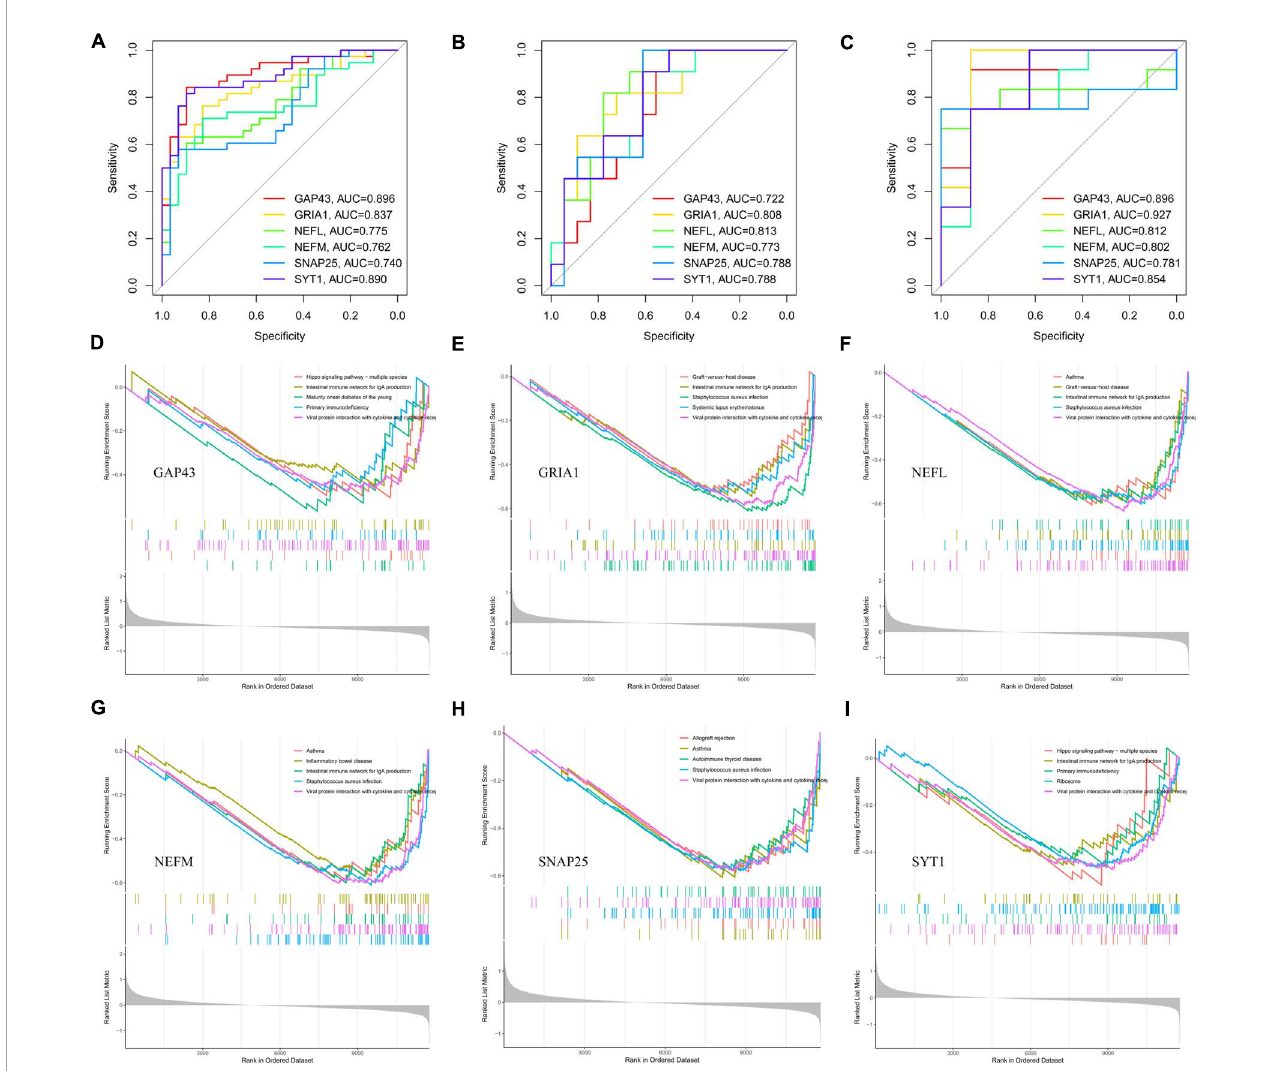
FIGURE7 Diagnostic efficacy of potential biomarkers (GAP43, GRIA1, NEFL, NEFM, SNAP25, and SYT1) for prediction of PD and GSEA based on expression levels of those potential biomarkers. ROC analysis of six hub genes (GAP43, GRIA1, NEFL, NEFM, SNAP25, and SYT1) for diagnosing PD in the integrated dataset (A) and the validation sets GSE20292 (B) and GSE26927 (C) . Single-gene GSEA-KEGG pathway analysis of GAP43 (D) , GRIA1 (E) , NEFL (F) , NEFM (G) , SNAP25 (H) , and SYT1 (I) . PD, Parkinson’s disease; GSEA, gene set enrichment analysis; ROC, receiver operator characteristic.